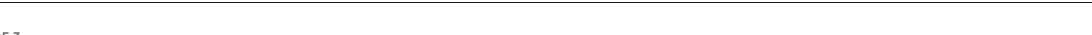
FIGURE3 Population structure of the five studied species as inferred by STRUCTURE and principal component analyses (PCA) analyses. Colors on the pie charts correspond to the proportion of each specimen assigned to each of the genetic clusters inferred for a given K value. For each species, both the optimal K value and an additional one showing a relevant geographical pattern with good statistical support, according to log probabilities of the data (LnPr ( X | K )), are presented. (A) Scatterplot of the first two PCA components is given for every species with a pie chart taken from one of the best K values associated with each locality. Main population breaks are marked with dashed and dotted lines. Parastalita stygia maps with K2 (A) , K3 (B), and PCA (C) ; Stalita pretneri maps with K3 (D) , K5 (E) and PCA (F) ; Troglohyphantes croaticus maps with K2 (G) , K5 (H) and PCA (I) ; Troglohyphantes excavatus maps with K2 (J) , K5 (K), and PCA (L) ; Troglohyphantes kordunlikanus maps with K2 (M) , K5 (N), and PCA (O) . In Troglohyphantes species PCAs (I,L,O) , pies denote clustering with K 5, and lines encircle K 2 grouping. Optimal K for each species is marked with an